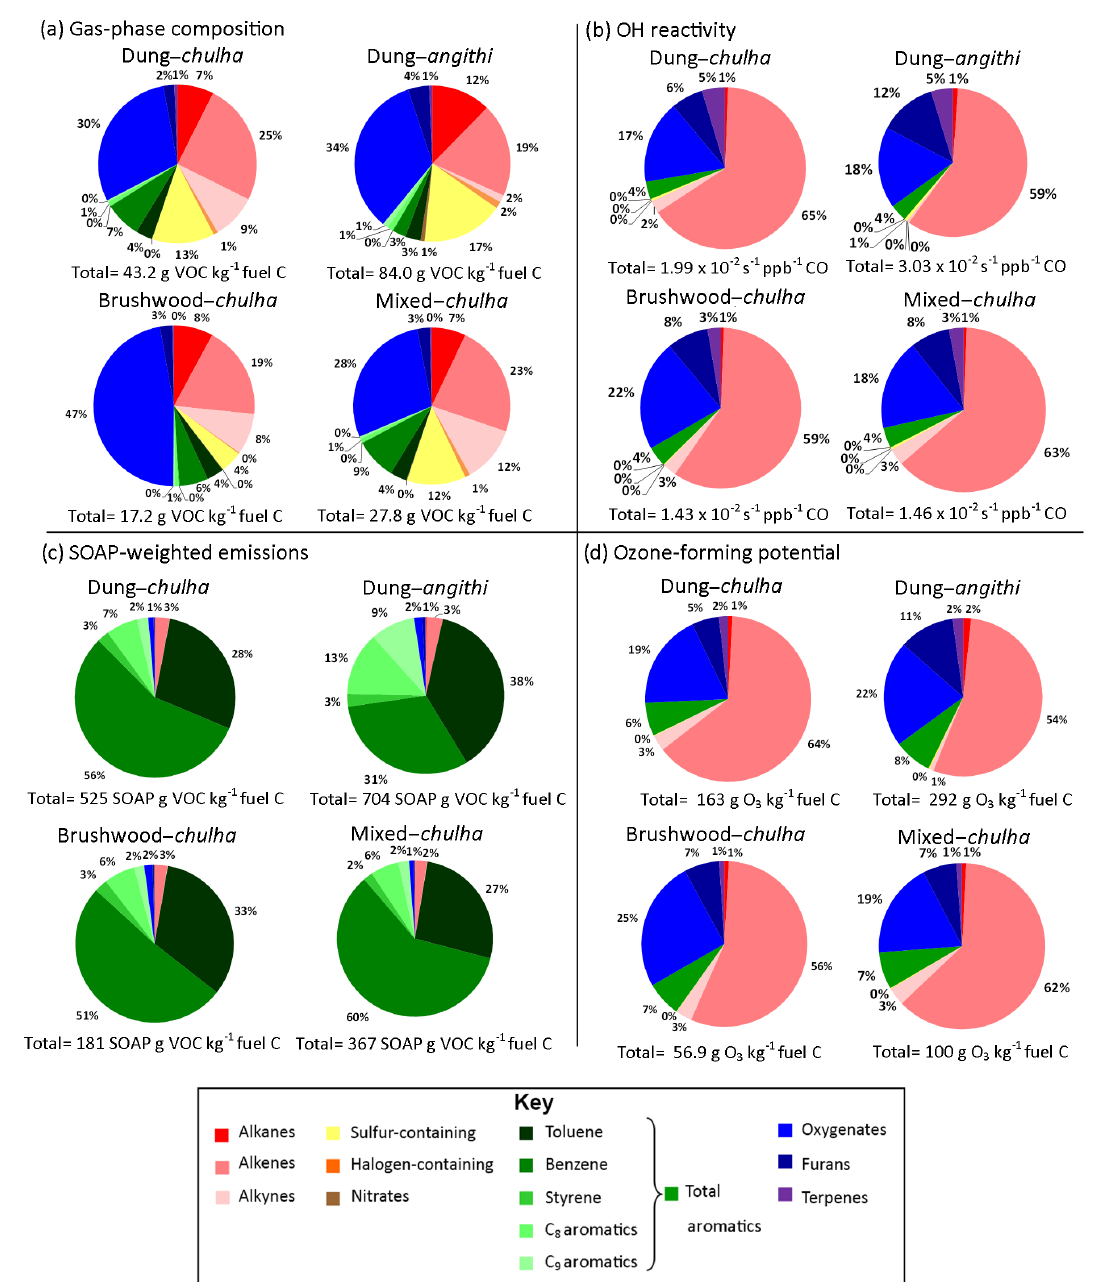
Figure 2. Pie charts showing the contribution of each species class to gas-phase composition (a) , OH reactivity (b) , SOAP-weighted emis- sions (c) , and ozone-forming potential (d) . For panels (b) and (d) , total aromatics are shown rather than the breakdown of aromatics shown in (a) and (c) . Sums of all components are shown below the pie chart. 1-Buten-3-yne is grouped in with